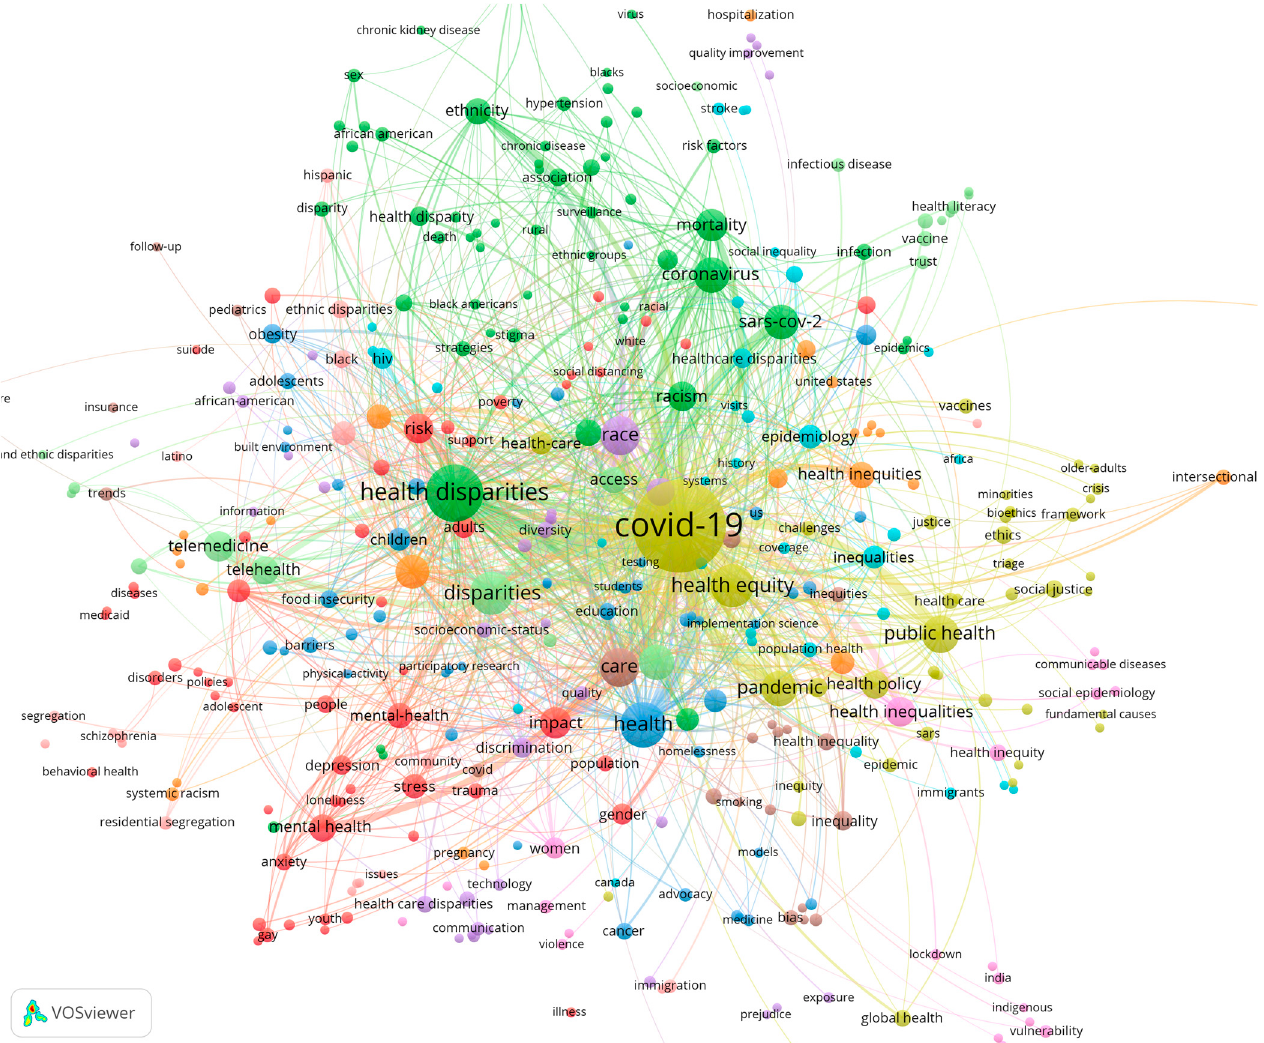
Figure 7. Keyword co-occurrence network. Note(s): The minimum number of occurrences of a keyword is 5. There are 384 keywords that meet the threshold.